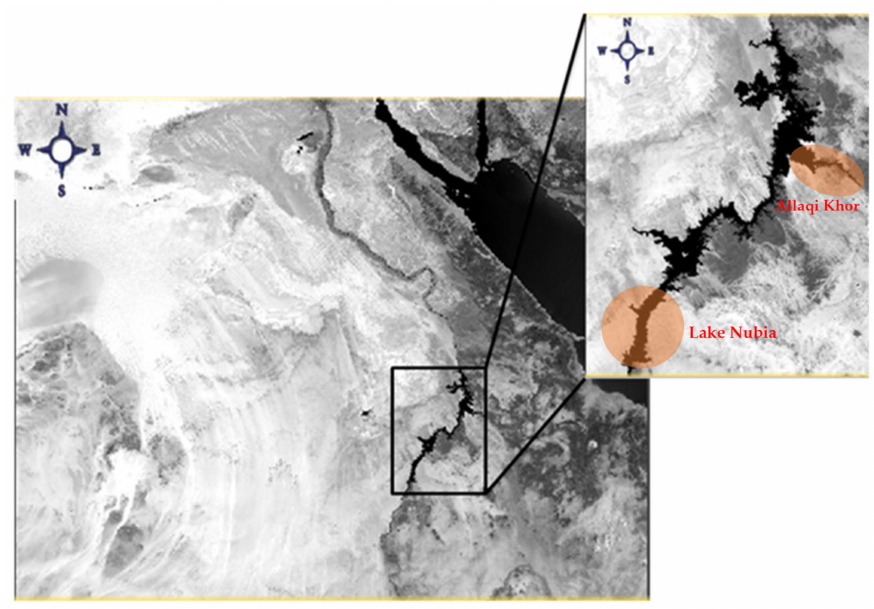
Figure 1. Aswan High Dam Lake, selected area shows Nubia Lake and Allaqi Khor, area clipped from Sentenel-3 image shows most of Egypt and the Red Sea in the footprint (image taken in October